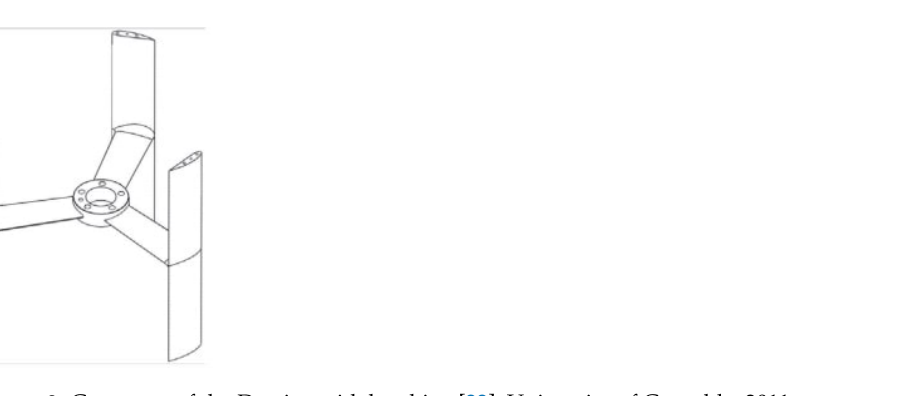
Figure 2. Geometry of the Darrieus tidal turbine [22], University of Grenoble,